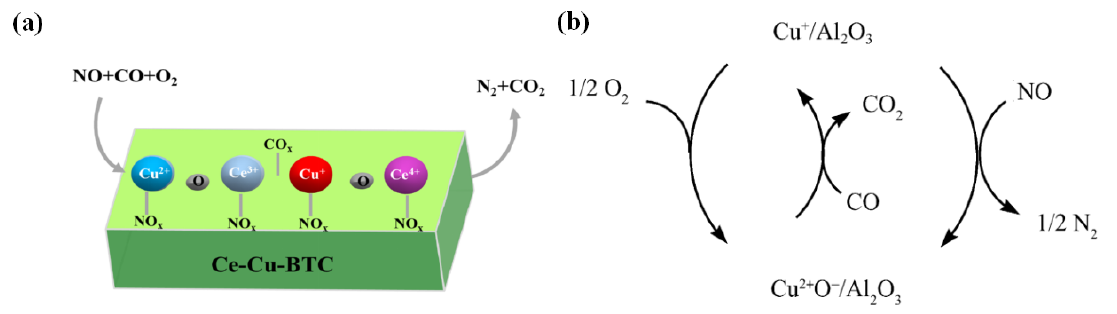
Figure 6. The reaction mechanism of Ce-Cu-BTC ( a ) and low-loaded CuO/Al 2 O 3 (0.5 wt.% Cu) ( b ) for CO-SCR in the presence of O 2 . Reproduced from [34,37] with